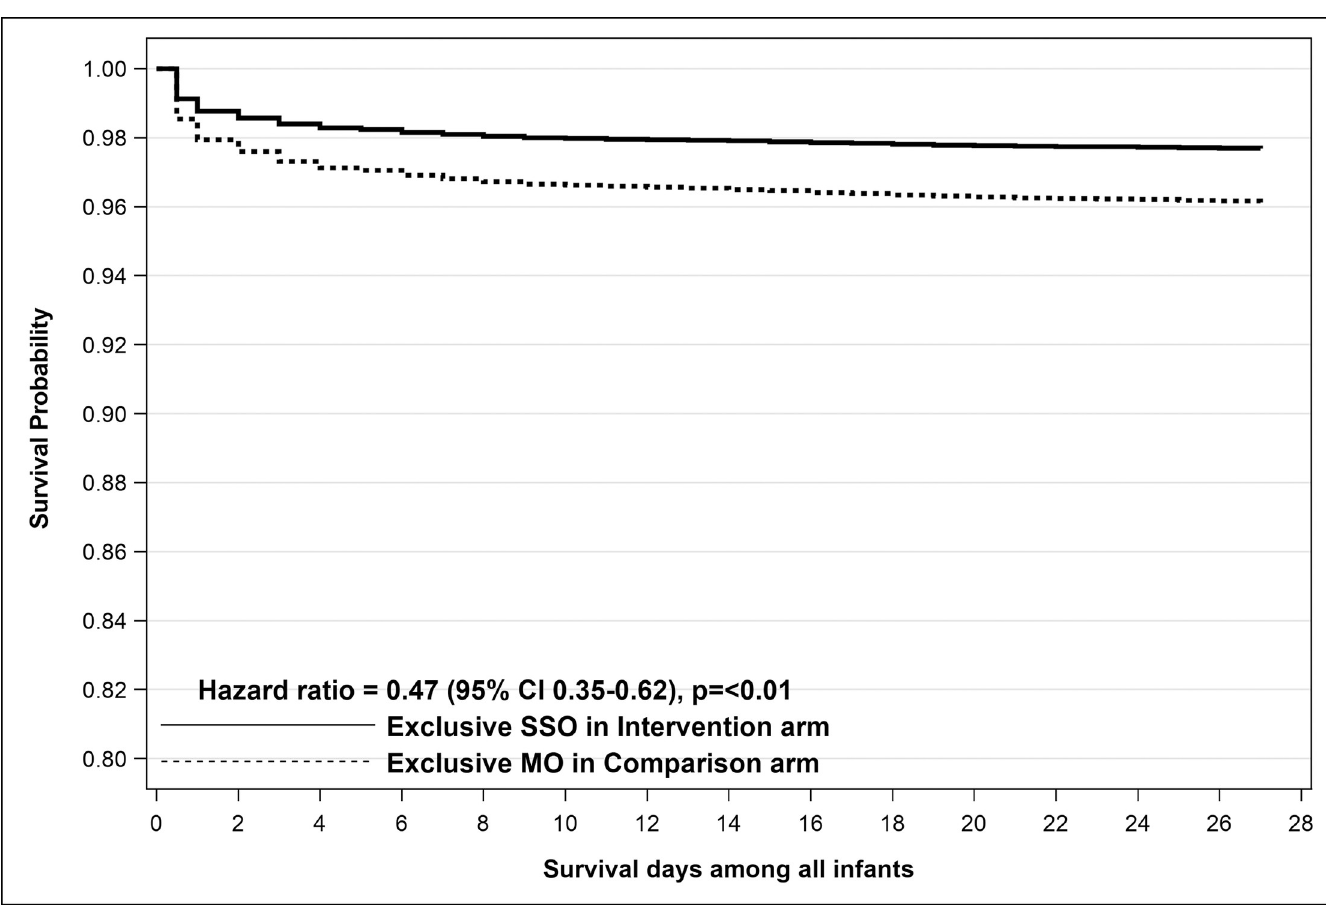
Fig 4. Kaplan–Meier survival curve for per-protocol analysis comparing all infants randomized to the intervention group and treated exclusively with SSO versus infants randomized to the comparison group who exclusively received mustard oil. CI, confidence interval; MO, mustard oil; SSO, sunflower seed oil.